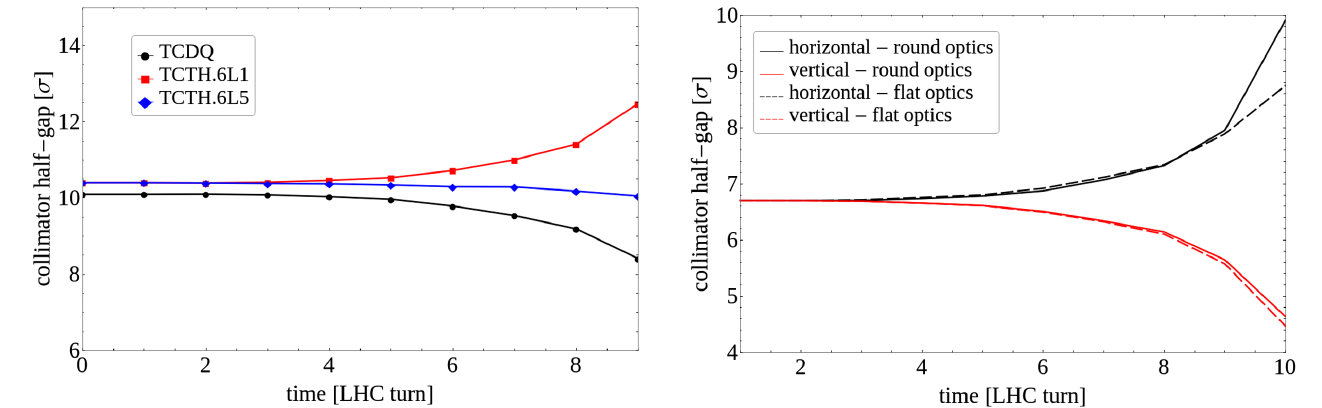
FIG. 12. The effective gap settings of the horizontal and vertical primary collimators during a CLIQ discharge in the Q2 right of IP5, round optics, or the Q2 right of IP1, flat optics.